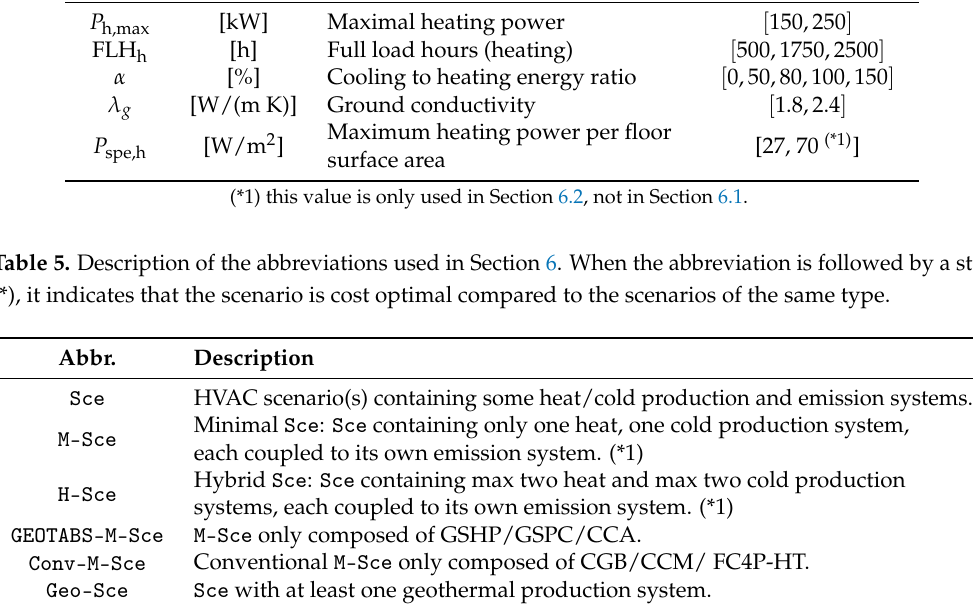
Table 4. Symbol, units, description and possible values of the different parameters used in Section 6. Symbol Units Description Considered Values P h,max [kW] Maximal heating power [ 150,250 ] FLH h [h] Full load hours (heating) [ 500,1750,2500 ] α [%] Cooling to heating energy ratio [ 0,50,80,100,150 ] λ g [W/(m K)] Ground conductivity [ 1.8,2.4 ] Maximum heating power per floor P spe,h [W/m 2 ] [27, 70 (*1) ] surface area